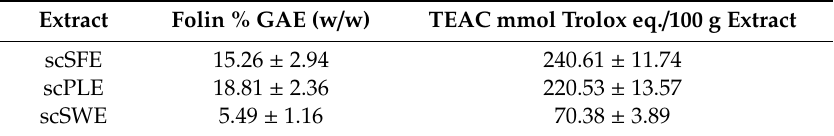
Table 3. Percentage of gallic acid equivalents (GAE) ± standard deviation (SD) determined by the Folin-Ciocalteu assay and antioxidant capacity in millimole (mmol) Trolox eq. / 100 g extract ± SD, determined through Trolox equivalent antioxidant capacity (TEAC) for scSFE, scPLE, and scSWE.